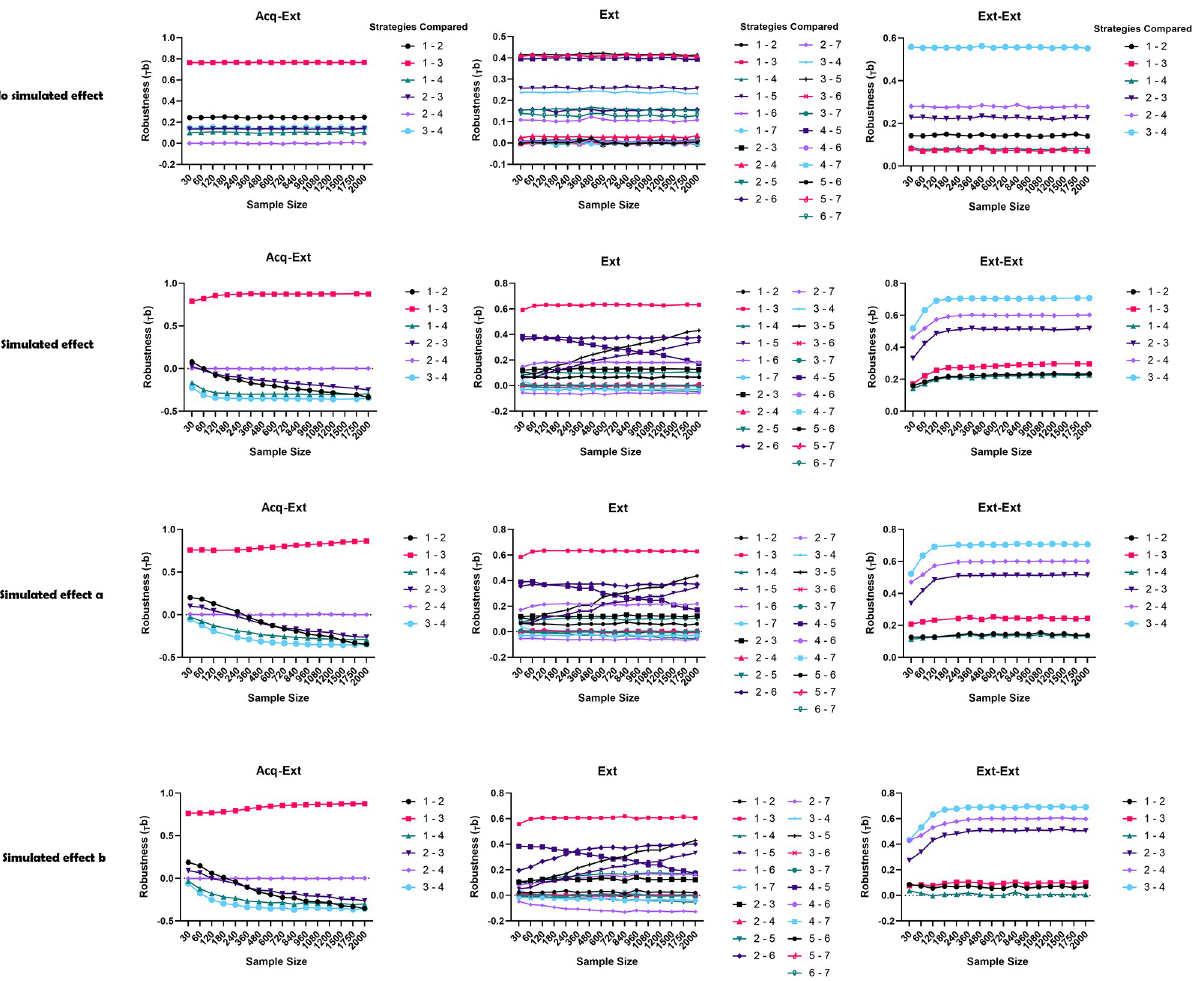
Fig 2. Effect of sample size on average Kendall’s rank order effect size ( ) between statistical strategies attempting to elicit the same construct Τ b from different data sets. Higher Τ b implies higher robustness. Top panel is data without simulated group-level effect, second panel simulates rapid decreasing differential conditioning during acquisition, third panel simulated gradual decrease in differential conditioning during acquisition, fourth panel simulated no change in differential conditioning during acquisition or early